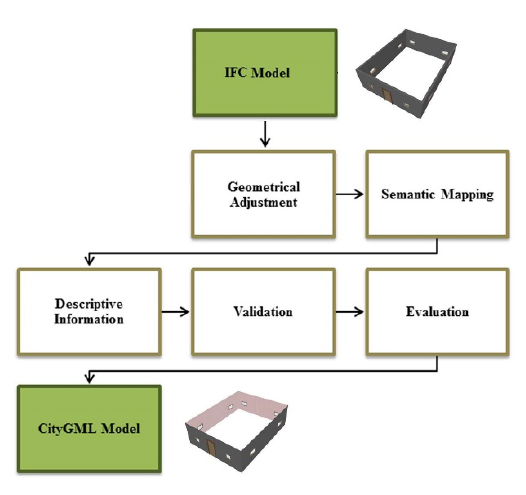
Figure 3: Workflow of the methodology